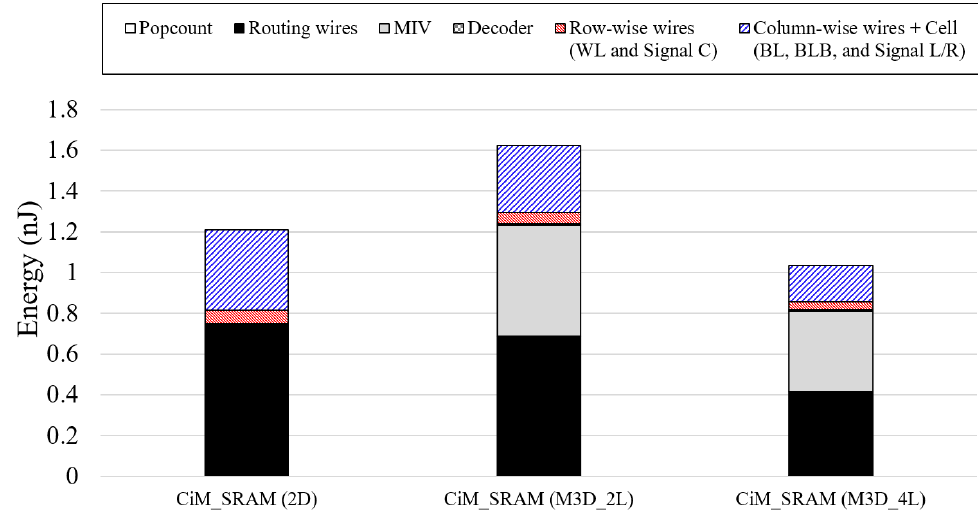
Figure 6. Energy consumption for different CiM_SRAM designs.